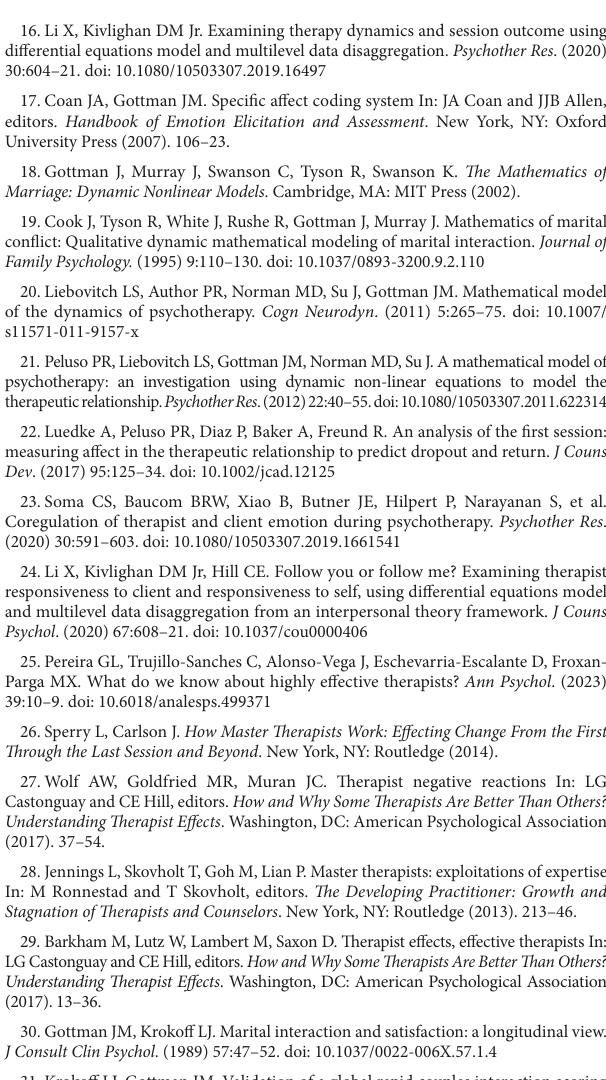
SUPPLEMENTARY FIGURE S1 Influence Functions and Phase-Space Portrait for Generic Model. SUPPLEMENTARY FIGURE S3 Time Series scatterplots of SPAFF scores for all six sessions of therapy between Jon Carlson and Aime. (A) is the phase portrait for session 1, (B) is for session 2, (C) is for session 3, etc. Colors denoted by the bar on the right signify the time (in seconds) in the session for the data